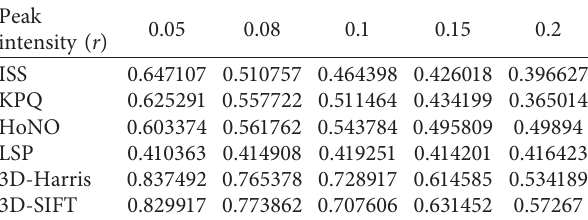
Table 4: Gaussian noise repetition rate r algorithm on Space Time data set.